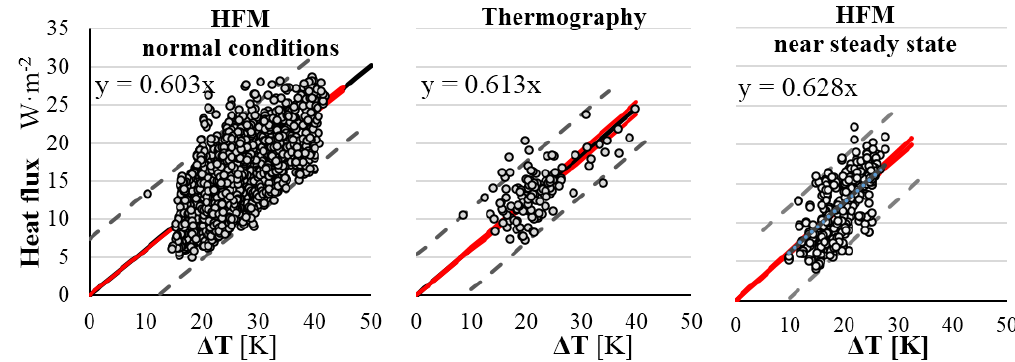
Figure 5. The thermal transmittance of the small wall segment for the north wall determined using heat flux sensors (HFMs) (left figure), thermography (centre figure) and HFMs during near steady-state conditions (right figure) with confidence interval of 95% certainty (red lines). The Y-axis represents the conduction heat flux Q Cond measured by HFMs (right and left figures) or Q Cond,Small wall calculated by Equation (6) for thermography (centre figure). The X-axis represents the difference between the indoor and outdoor ambient air temperatures, ∆ T = (T Indoor – T Outdoor ). The dashed lines represent 95% certainty for measurements to disperse around the mean (black trend-line).